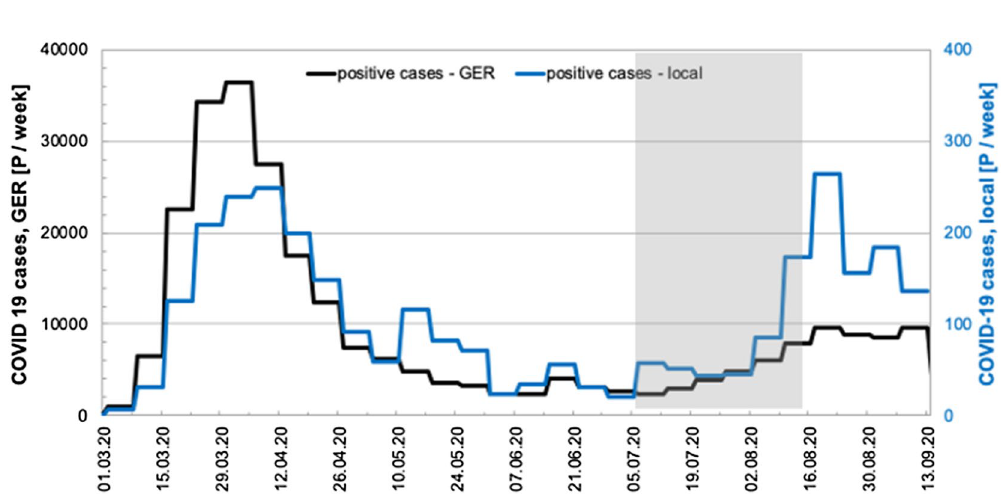
Figure 1. Graphical representation of the epidemiological data of COVID-19 cases in Germany (black line) and the city of Frankfurt am Main (blue line). The grey area indicates the time of the summer school vacation in the State of